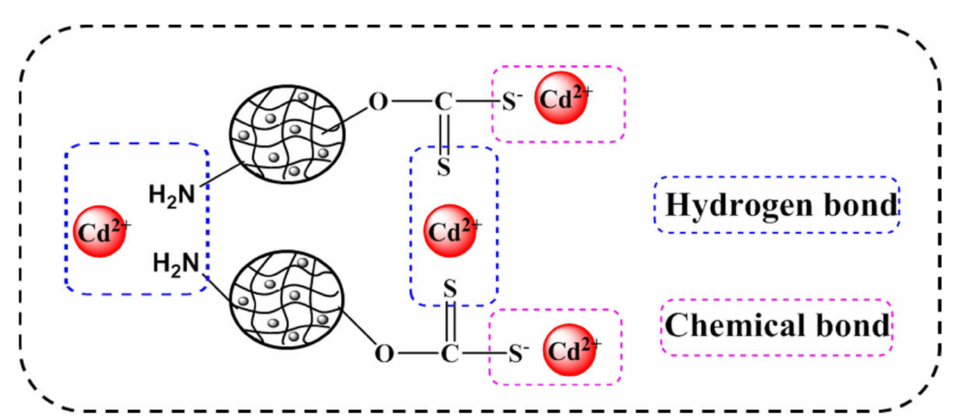
Figure 5. Proposed adsorption mechanism using the XMPC capture of Cd(II).